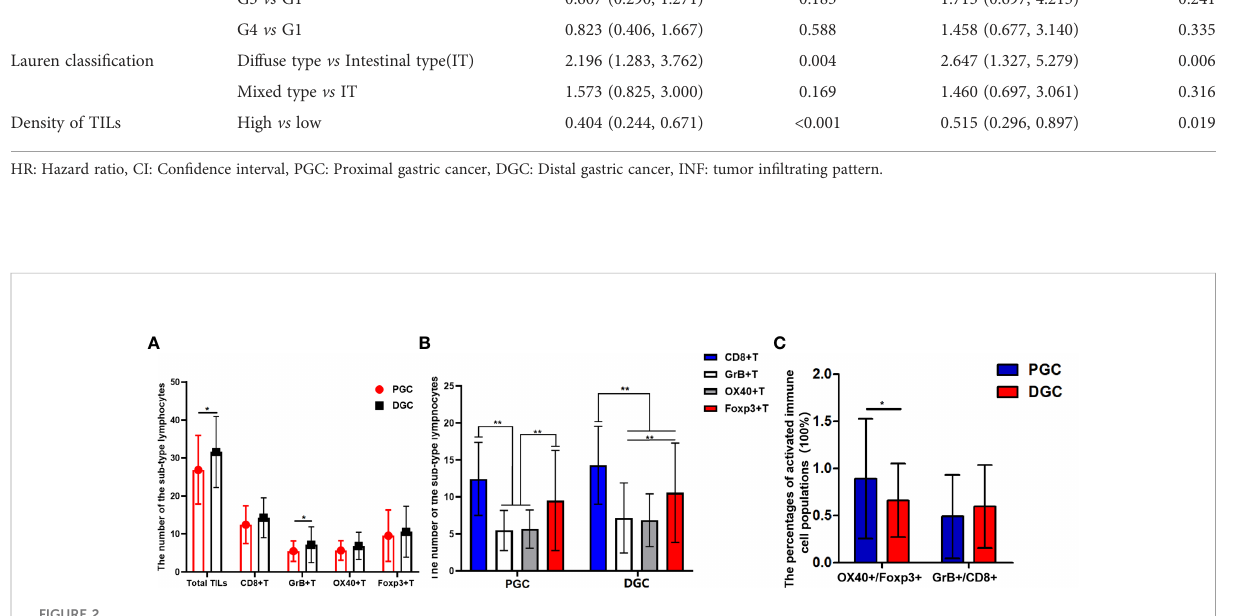
FIGURE 2 (A, B) Graphs showing the four sub-types of tumor-in fi ltrating lymphocytes (TILs) distribution in proximal gastric cancer (PGC) and distal gastric cancer (DGC). The total number of TILs ( P = 0.033) and the GrB+T ( P = 0.003) cell in fi ltrates were signi fi cantly attenuated in PGC (A) . The CD8+T cells possess a numerical advantage in DGC ( P < 0.001) as for the investigated sub-type of immune cells. The number of Foxp3+T cells was also quantitatively superior to OX40+T ( P < 0.001) and GrB+T ( P < 0.001) cells in DGC and PGC (B) .The functional Treg cell (OX40+/FOXP3+) percentage was signi fi cantly higher in the PGC compared with that in DGC ( P = 0.009) (C) . The degree of difference is expressed by the asterisk symbols: **P < 0.001 and *P <